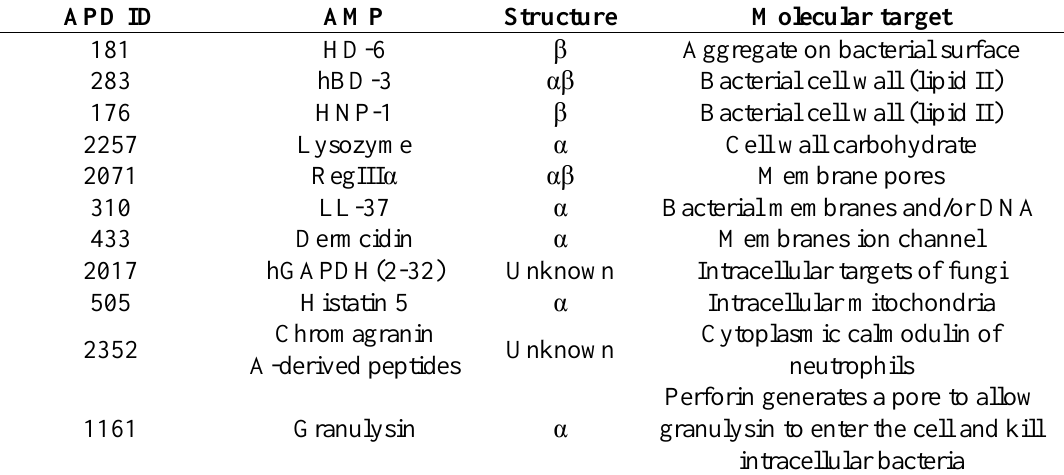
Table 3. Select human antimicrobial peptides and their proposed